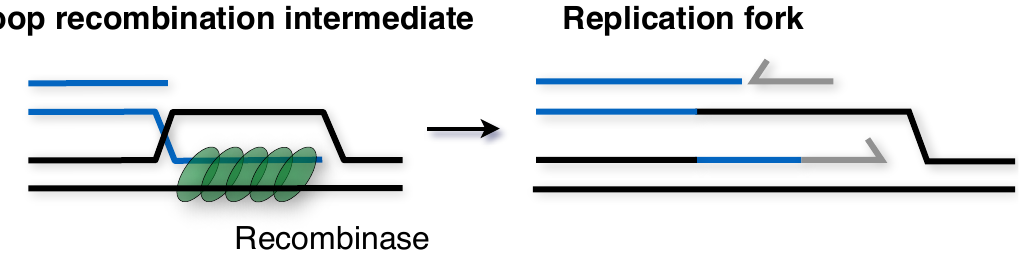
Figure 4. Recombination-dependent replication initiation. The invading 3 (cid:48) DNA end of a displacement loop (D-loop) recombination intermediate is used as a primer for leading strand DNA synthesis. Formation of a D-loop requires a RecA-family